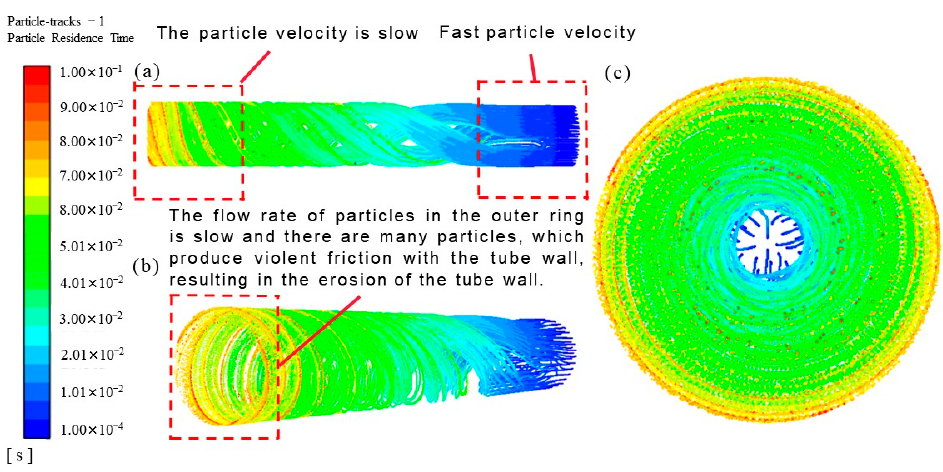
Figure 7. Particle track of downhole solid–liquid separator. ( a , b ) Side view; ( c ) front view .